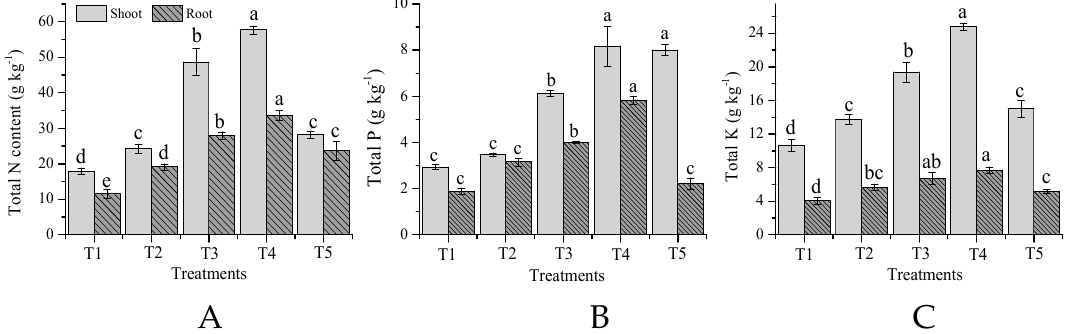
Figure 2. Influences of co-application of TW and chemical fertilizers on N ( A ), P ( B ), and K ( C ) uptake in shoot and root of wheat. Without amendment (T1), chemical fertilizers (T2), TW 2.5% + F (T3), TW 5% + F (T4) and TW 10% + F (T5). Data showed the mean of three replications, and error bars are standard deviations. Different letters indicate there were significant differences ( p < 0.05) in the LSD means comparisons between the treatments mean.